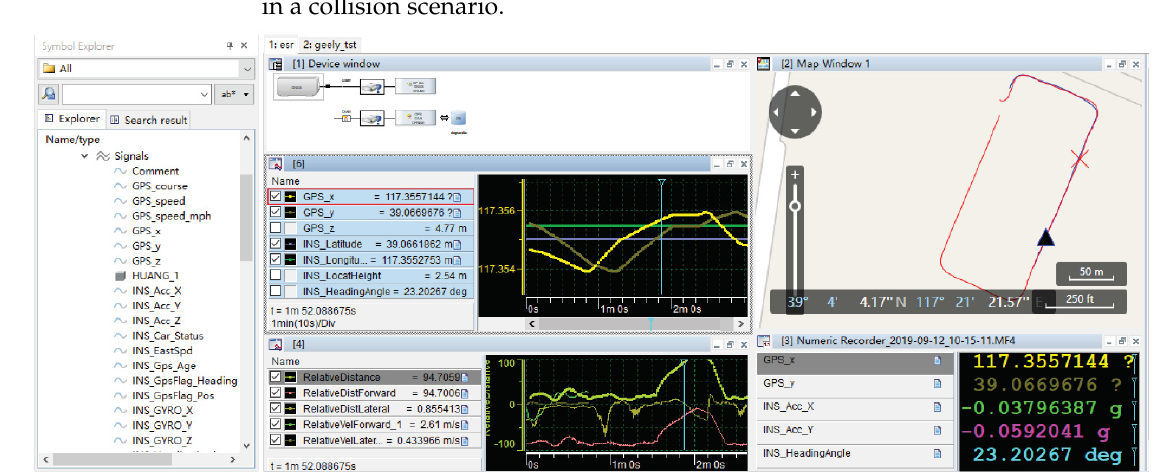
Figure 20. Visualization interface based on CANape17.0.